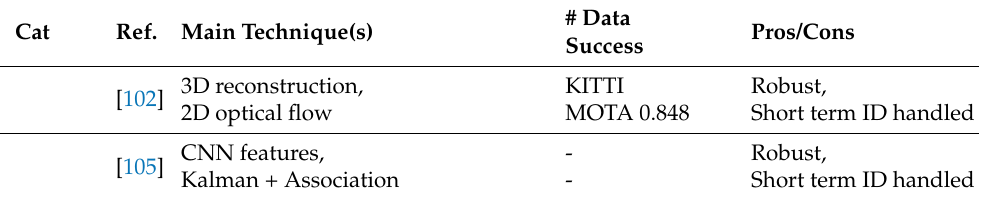
Table 10. Performance evaluation of the reviewed vehicle ReID Tracking